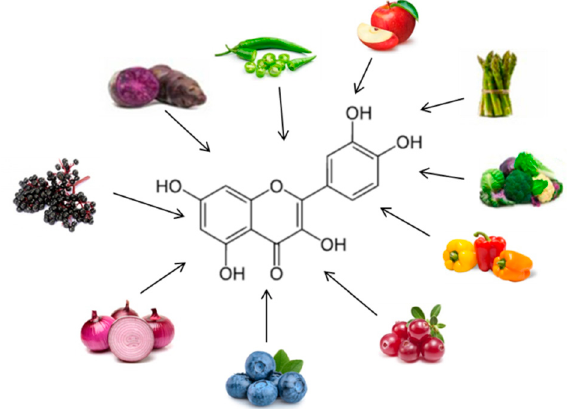
Figure 5. Chemical structure and major sources of quercetin.